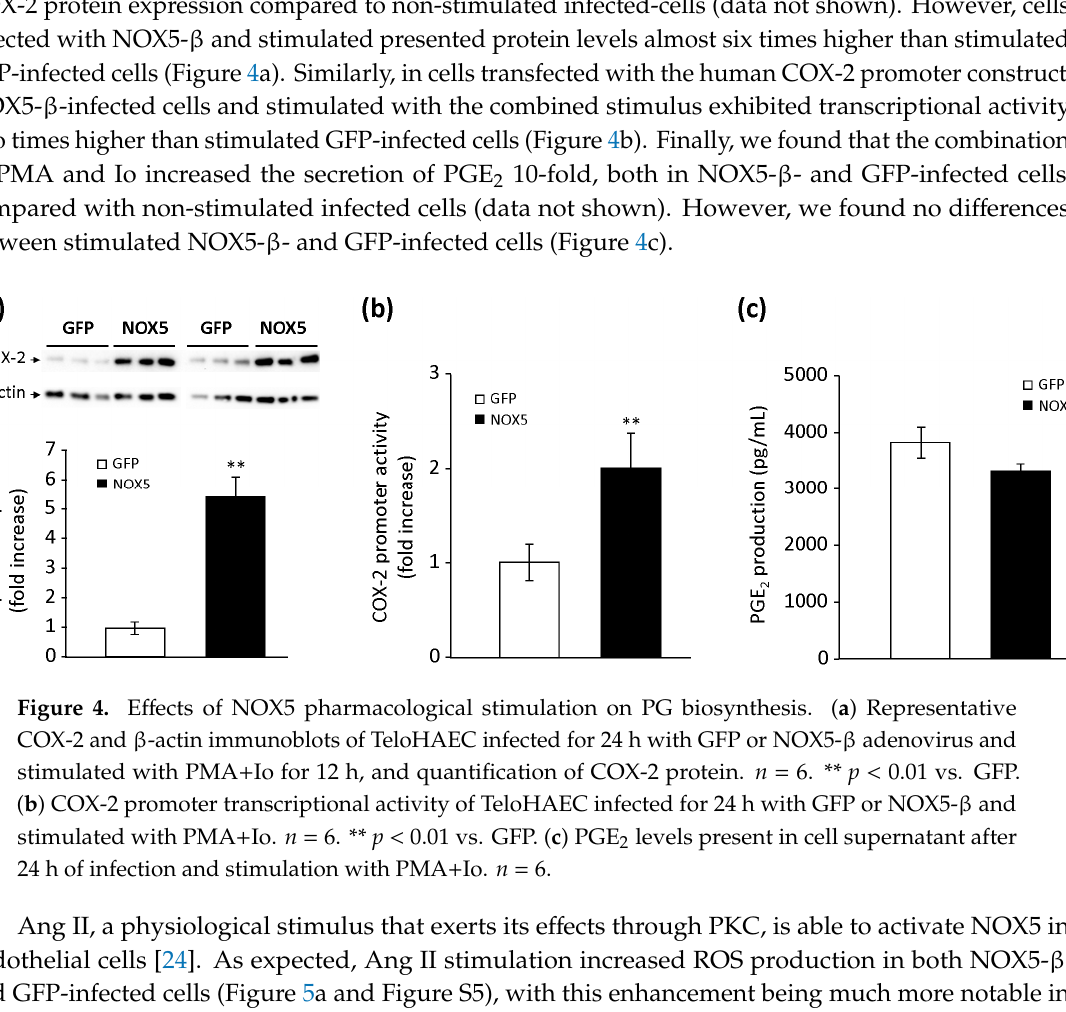
Figure 3. Characterization of NOX5 pharmacological stimuli in infected TeloHAEC. ( a ) ROS production measurements in NOX5- β - and GFP-infected cells for 24 h, and then stimulated with phorbol 12-myristate 13-acetate (PMA). n = 6. **** p < 0.0001 vs. non-stimulated GFP, #### p < 0.0001 vs. non-stimulated NOX5, and xxxx p < 0.0001 vs. GFP+PMA. ( b ) ROS production measurements in NOX5- β -infected cells for 24 h, and then stimulated with PMA, ionomycin (Io), or a combination of both. n = 6. * p < 0.05 vs. non-stimulated NOX5, **** p < 0.0001 vs. non-stimulated NOX5, and #### p < 0.0001